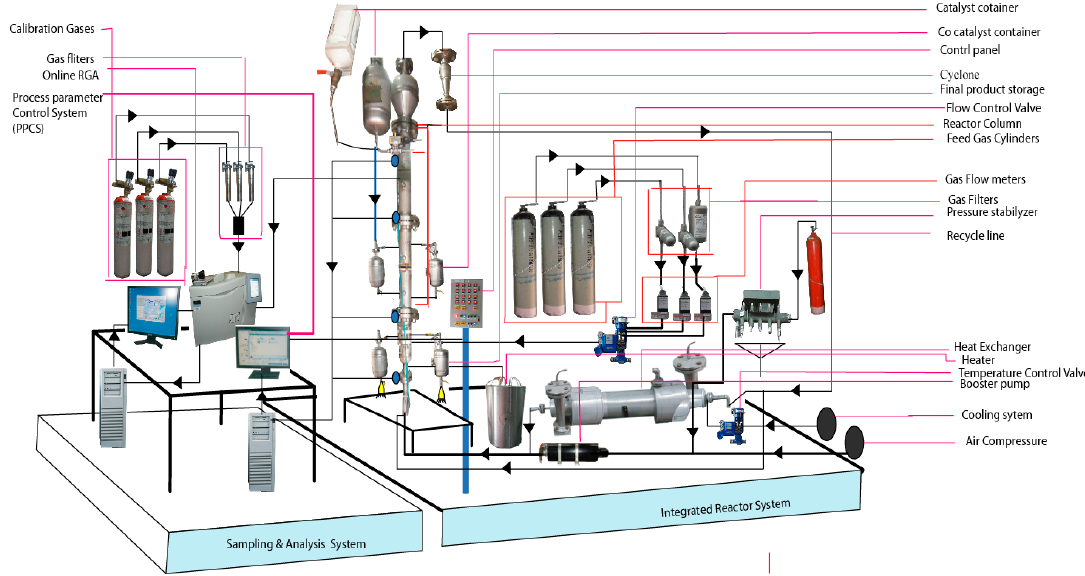
Figure 2. Sampling and analysis system integrated with a pilot scale fluidised bed catalytic reactor.